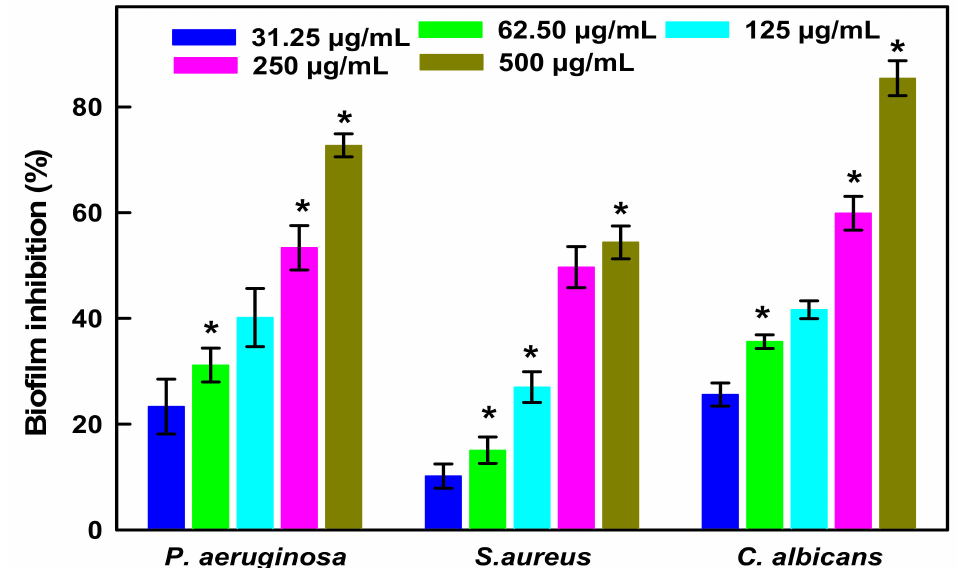
Figure 9. Antibiofilm activities. LIV-AgNPs concentration dependent inhibition in biofilm formation of MDR-PA, MRSA and C. albicans strains. The error bars represent mean ± S.D. of two independent experiments done in triplicates. * p < 0.05 versus